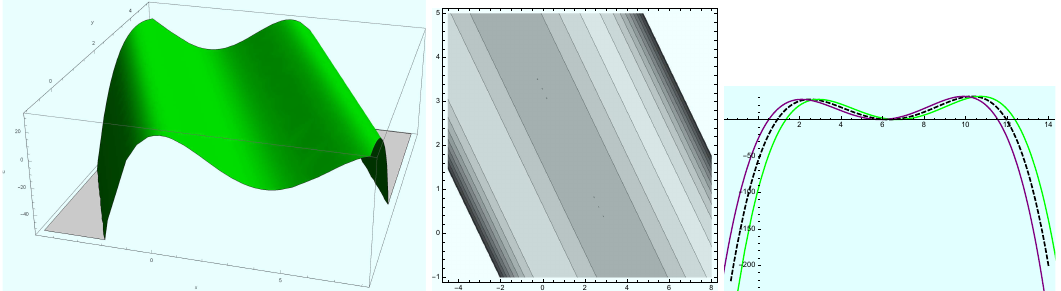
Figure 17. Evolution of traveling wave of series solution (34) at t = − 1 and z = −